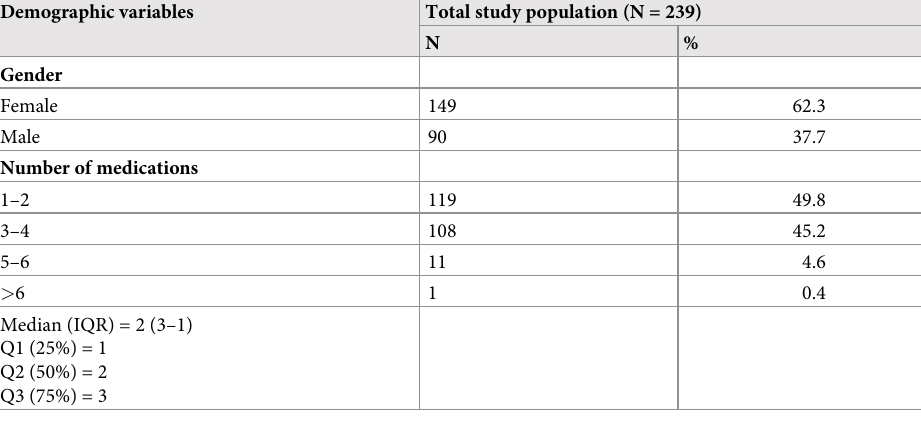
Table 1. Patient